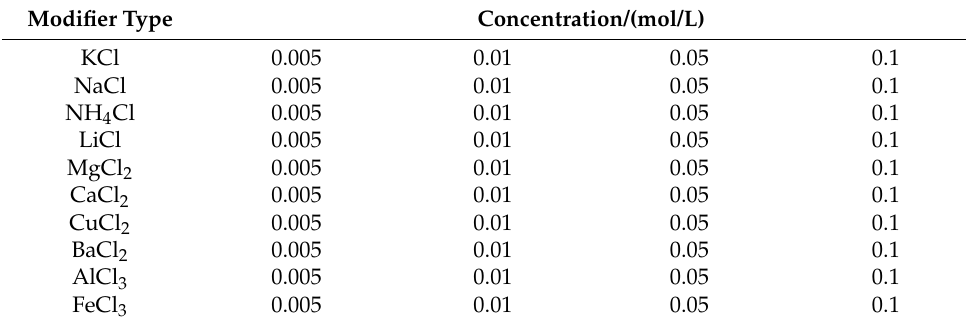
Table 2. Parameter of modifier solution.